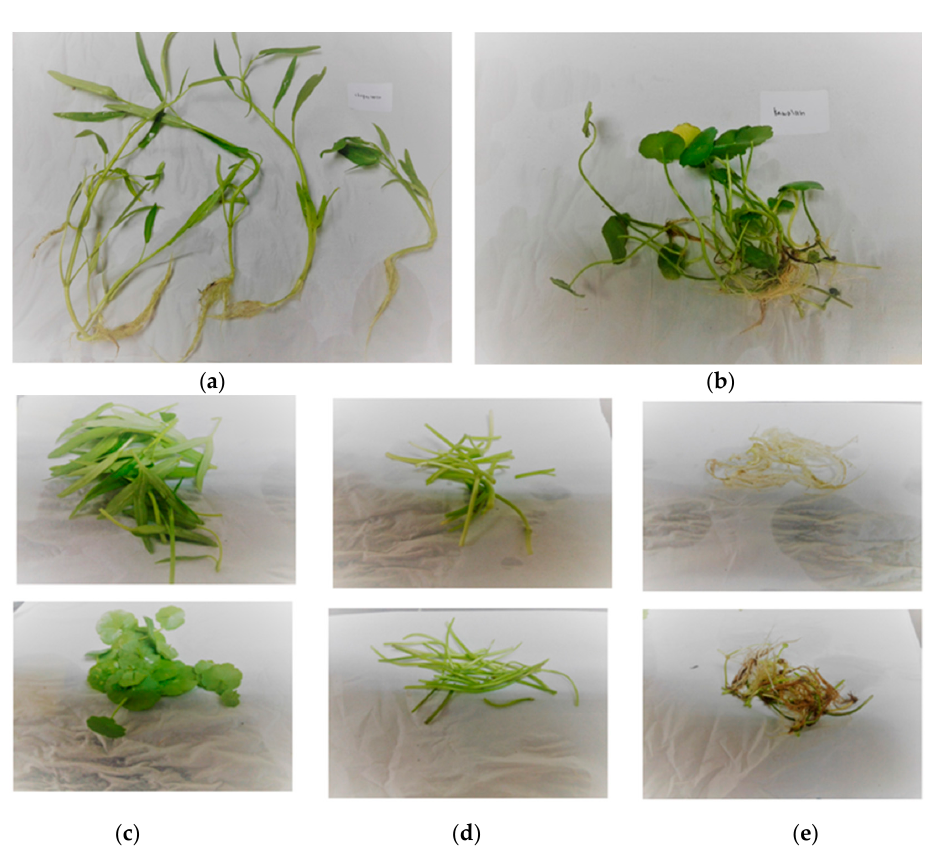
Figure 2 . Harvesting process of ( a ) Ipomoea aquatica and ( b ) Centella asiatica , and the separation of; ( c ) leaves, ( d ) stems, and ( e ) roots of Ipomoea aquatica and Centella asiatica .